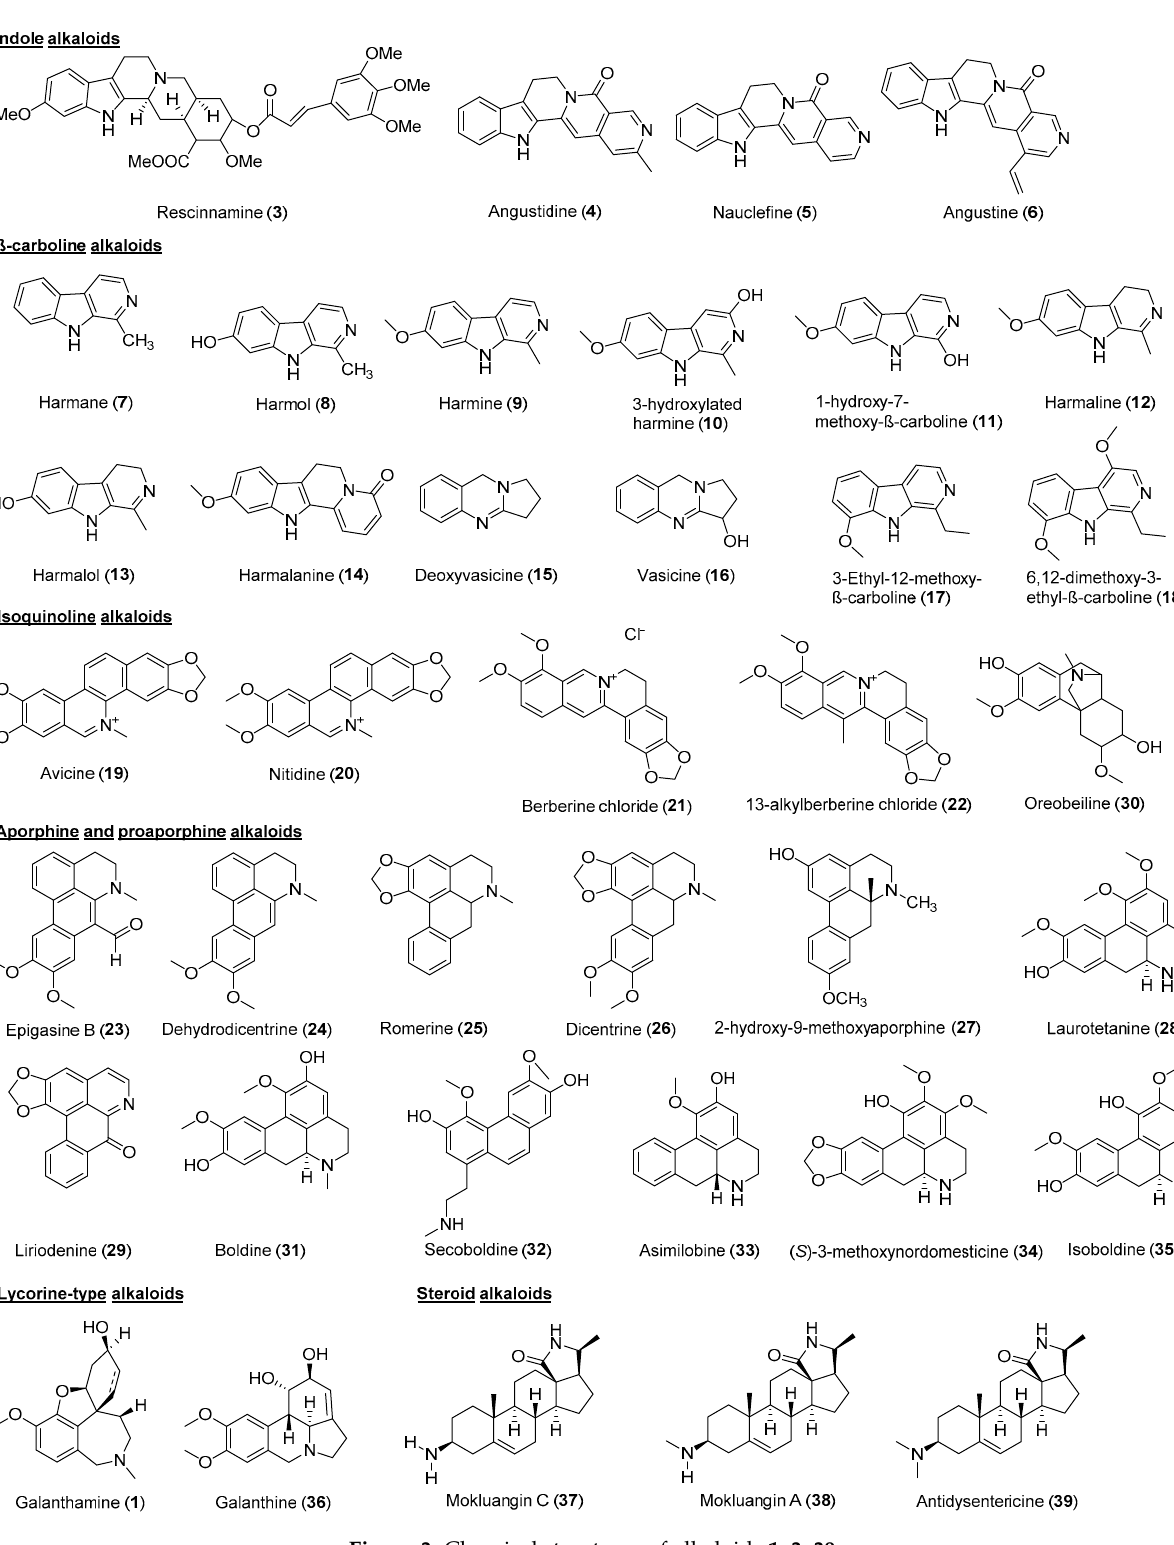
Figure 3. Chemical structures of alkaloids 1 , 3 – 39 .